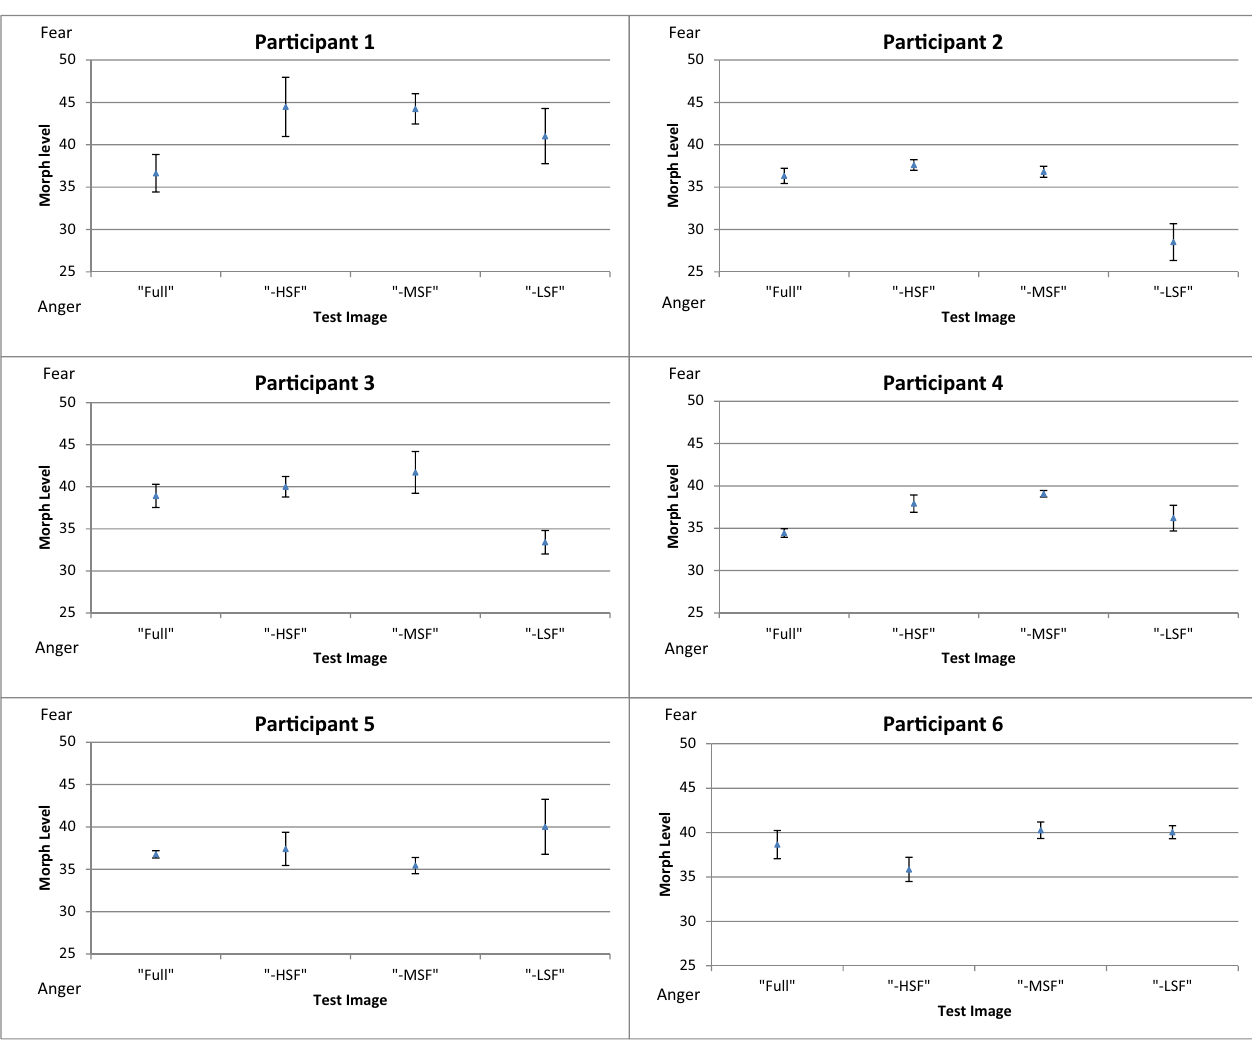
FIGURE 3 | Mean thresholds of morph level for the four conditions (full-bandwidth, -HSF, -MSF, and -LSF) for participants in Experiment 1 . Error bars show ± 1 standard error of the